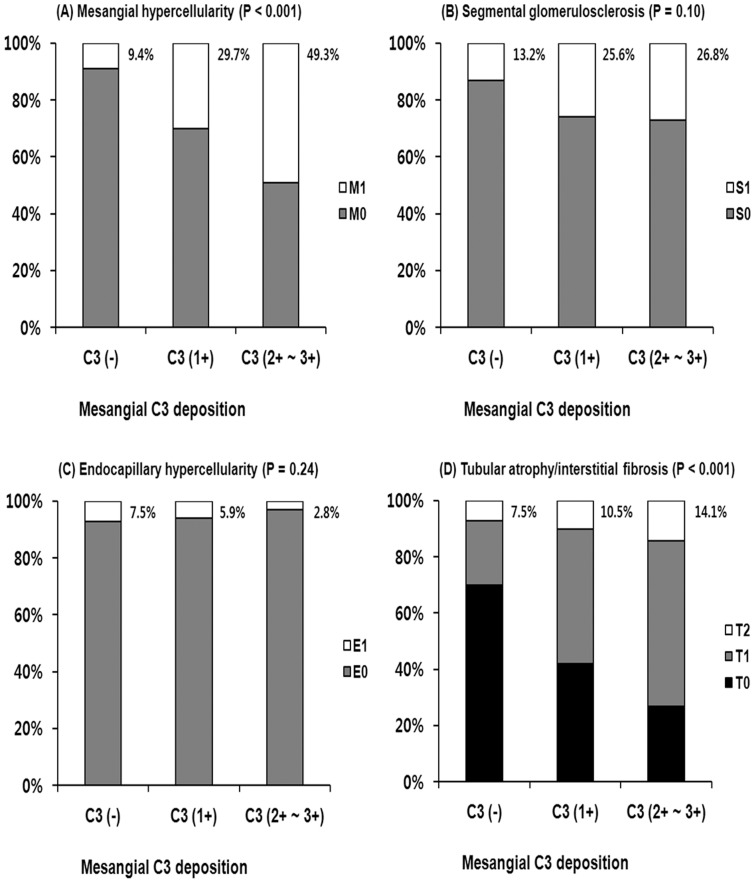
The histopathologic grades such as (A) mesangial hypercellularity, (B) segmental glomerulosclerosis, (C) endocapillary hypercellularity, and (D) tubular atrophy/interstitial fibrosis according to mesangial C3 deposition.Mesangial hypercellularity (C3 deposition 0, 9.4%; 1+, 29.7%; 2+∼3+, 49.3%; P<0.001) and high-grade tubular atrophy/interstitial fibrosis (C3 deposition 0, 7.5%; 1+, 10.5%; 2+∼3+, 14.1%; P<0.001) were more prominent as the mesangial area of C3 deposition increased.